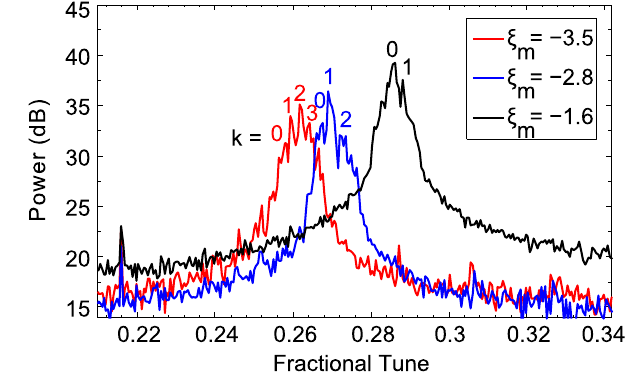
FIG. 21. Analytical curves from Eq. (9) (dotted) are fitted to the local transverse offset for the k ¼ 0 , 1, and 2 modes with the head-tail phase shift as the fit parameter. Data from only three consecutive turns is shown for clarity. This method has been used for the precise determination of the chromaticity.